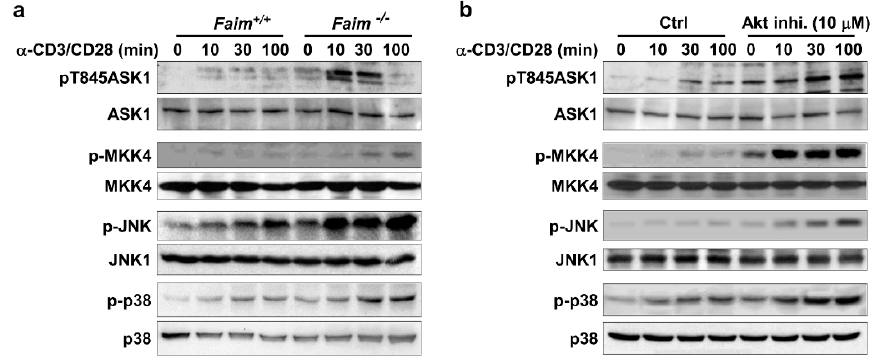
Figure 4. Akt negatively regulates ASK1-JNK/p38-Nur77 signaling in TCR-stimulated thymocytes. ( a ) FAIM-deficient thymocytes exhibit an enhanced activation of ASK1, MKK4, JNK, and p38 upon TCR engagement. Thymocytes from Faim +/+ and Faim -/- mice were stimulated with anti-CD3 (10 μ g/mL) and anti-CD28 (1 μ g/mL) antibodies for different periods of time, as indicated. Whole cell lysates were prepared and subjected to immunoblotting for the detection of the phosphorylation status of ASK1, MKK4, JNK, and p38. ( b ) The inhibition of Akt leads to enhanced ASK1-MKK4-JNK/p38 signaling in TCR-stimulated thymocytes. Thymocytes were stimulated with anti-CD3 (10 μ g/mL) and anti-CD28 (1 μ g/mL) antibodies for different periods of time as indicated, in the absence or presence of the Akt inhibitor. The phosphorylation status of ASK1, MKK4, JNK, and p38 was examined, as described in Figure 4a. The amount of ASK1, MKK4, JNK1/2, and p38 was also detected and included as loading controls for the individual proteins. The data shown are representative of more than four independent experiments.